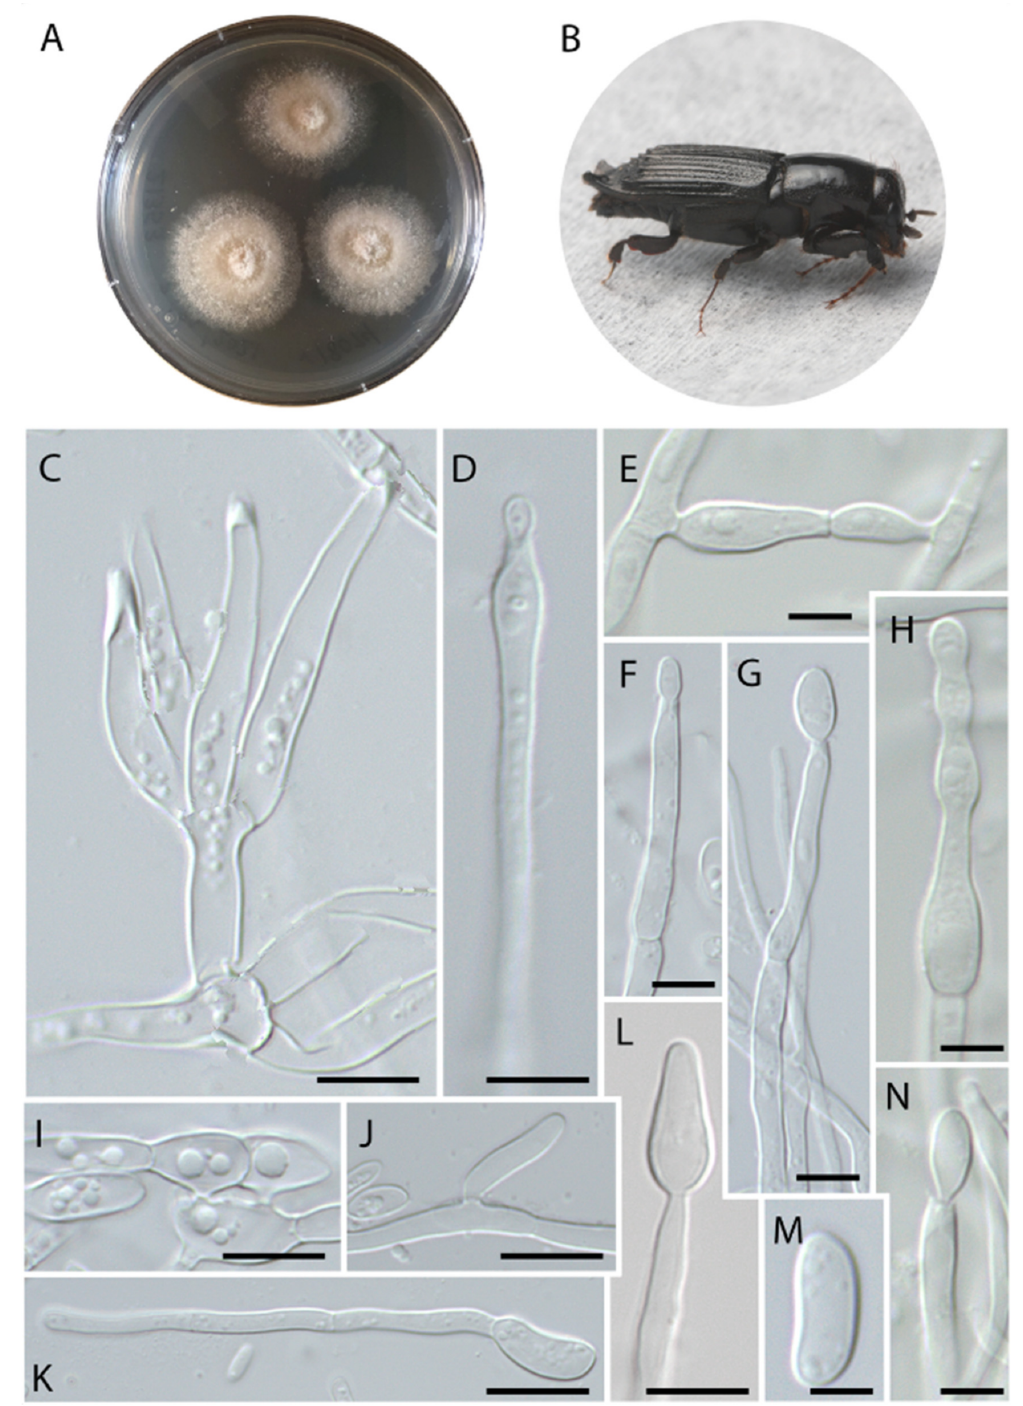
Figure 5. Raffaelea sporodochialis in pure culture on PDA. ( A ) Colony growth after 3 weeks at 25 ◦ C. ( B ) Beetle vector, Megaplatypus godmanii . ( C ) Sporodochia composed of 4 phialides formed from a single basal cell. ( D ) Early developmental stage of aleuriospore. ( E ) Anastomosing hyphae. ( F – H ) Aleuriospores. ( I ) Anasmotomozing cells, presumably aiding transfer of nutrients throughout the hyphae. ( J ) Sessile conidia. ( K ) Germinating conidium. ( L ) Aleuriospore. ( M ) conidium. ( N ) Aleuriospore being produced at the hyphal tip. Scale bars: ( C ) = 10 µ m, ( D ) = 5 µ m, ( E , F ) = 3 µ m, ( G , H ) = 5 µ m, ( I , J ) = 10 µ m, ( K , L ) = 5 µ m, ( M , N ) = 3 µ